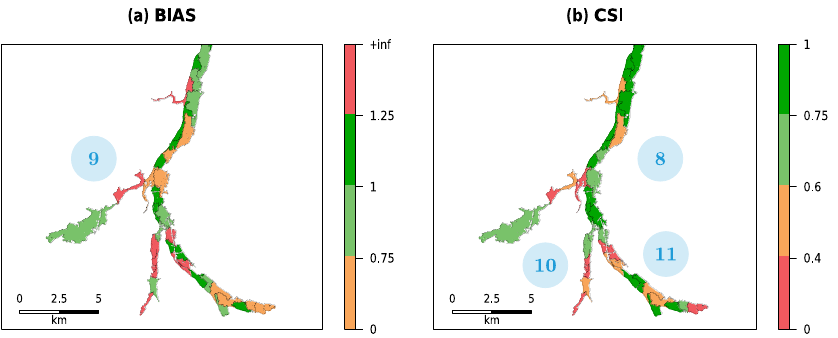
Figure 14. Reach-scale performance of (a) BIAS and (b) CSI for the physical combination of parameters, K ch = 10 and K fp = 5m 1 / 3 s − 1 , for the upstream part of the catchment. Criteria values have been categorised as follows: excellent (dark green), good (green), average (orange) and poor (red). The black lines delineate the reaches. Locations 8 to 11 correspond to areas where the model struggles to reproduce the observation (orange and/or red